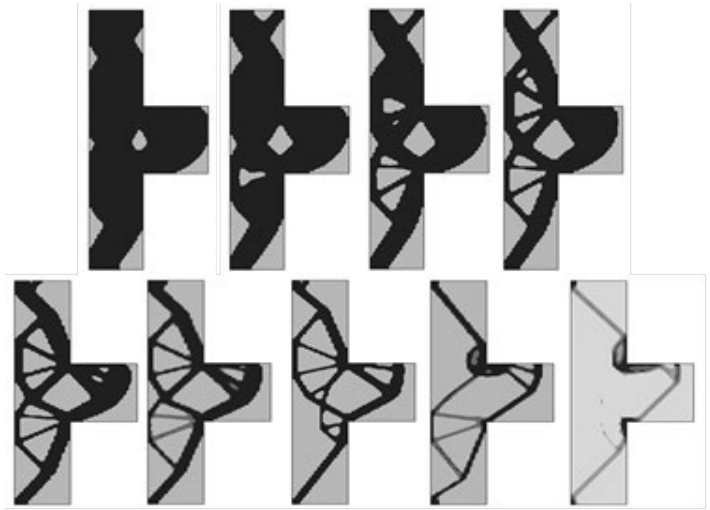
Figure 7. Optimized distribution of material, volume fractions of 90%, 80%, 70%, 60%, 50%, 40%, 30%, 20% and 10%, respectively.